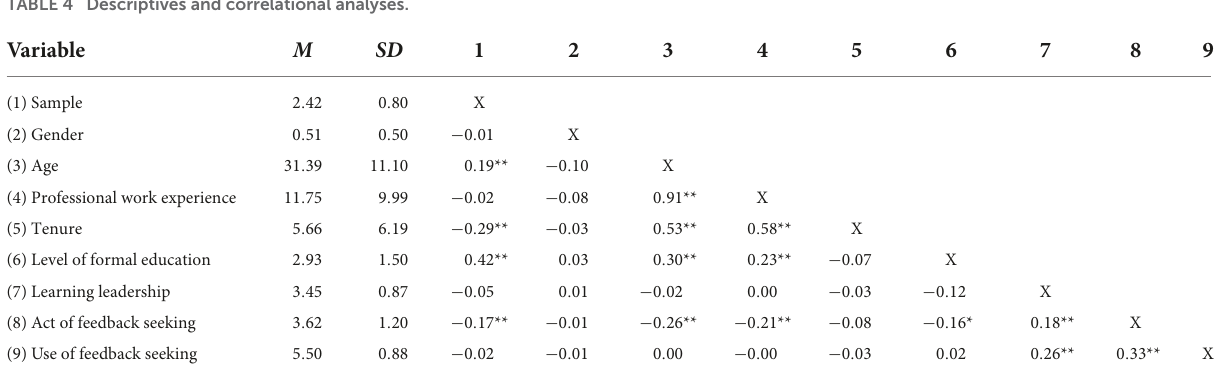
TABLE 4 Descriptives and correlational